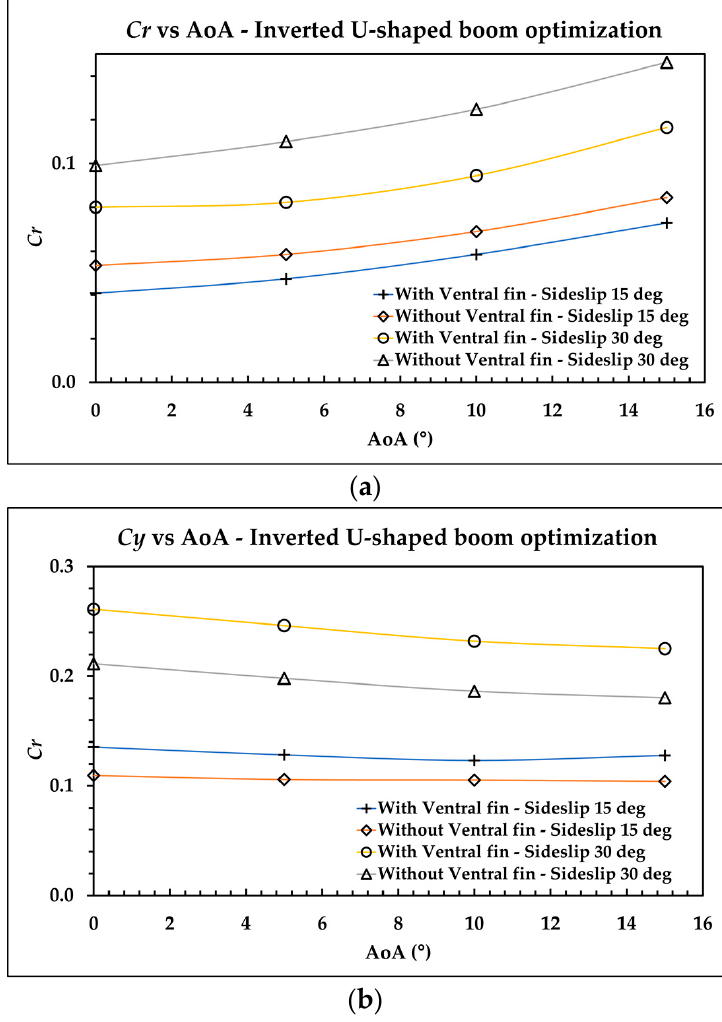
Figure 22. Stability optimization, ( a ) Lateral stability and ( b ) Directional stability.